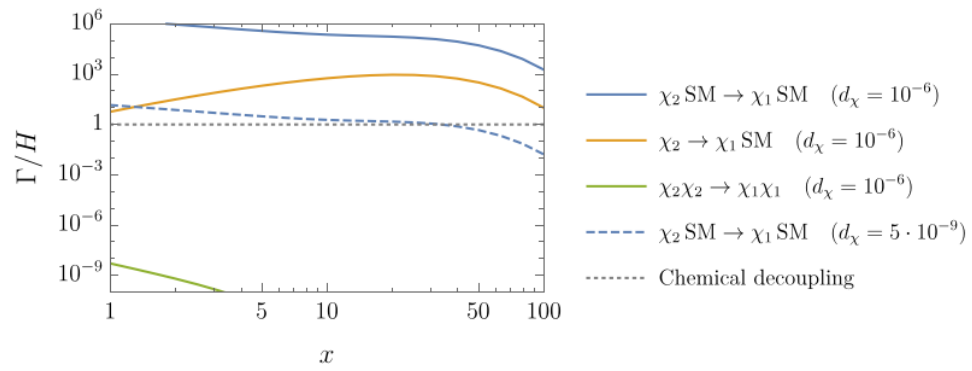
Figure 3 . Interaction rates for the case m 1 = 1 TeV and d (cid:31) = 10 (cid:0) 6 . Di(cid:11)erent choices for the mass of the DM give similar results, and the scattering with gluons always turns out to be the relevant contribution for the determination of departure from chemical